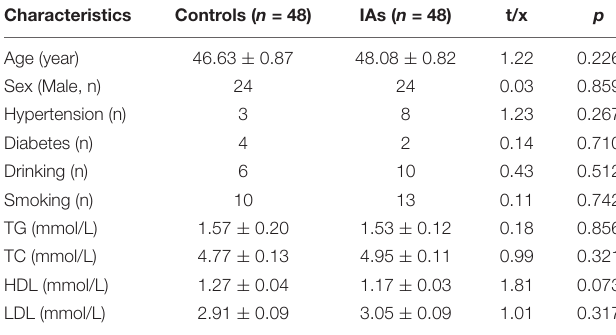
TABLE 1 | Clinical characteristics of all